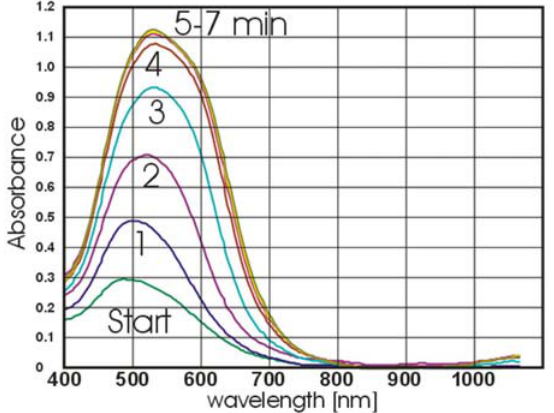
Figure 5. Spectral changes observed by binding of nanoparticles to antibodies deposited as a spot of 5 mm diameter in the